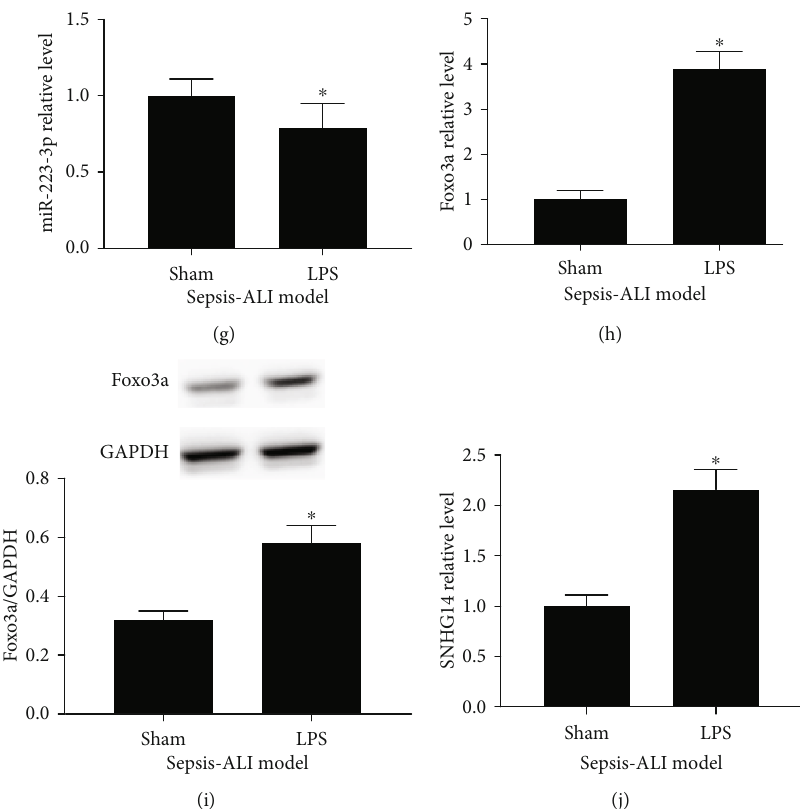
Figure 1: lncRNA-SNHG14/miR-223-3p/Foxo3a expression level altered in LPS-treated A549 cells and lung tissue collected from LPS- induced ALI models. (a) RNA-sequence analysis was used to reveal the microRNAs (left), mRNAs (middle), and lncRNAs (right) pro fi les in A549 cells treated by LPS for 24h. Di ff erentially expressed genes were shown in the volcano plot. According to the adjusted P value, the top ten di ff erentials expressed microRNAs (left), mRNAs (middle), and lncRNAs (right) were shown in heat maps. A549 cells were treated by LPS for 24h. miR-223-3p (c), Foxo3a mRNA (d), Foxo3a protein (e), and lncRNA-SNHG14 (f) were detected using qRT-PCR and western blot, respectively. Lung tissue samples were collected from LPS-induced ALI models. miR-223-3p (g), Foxo3a mRNA (h), Foxo3a protein (i), and lncRNA-SNHG14 (j) were measured. ∗ P < 0 : 05 compared with the control or Sham